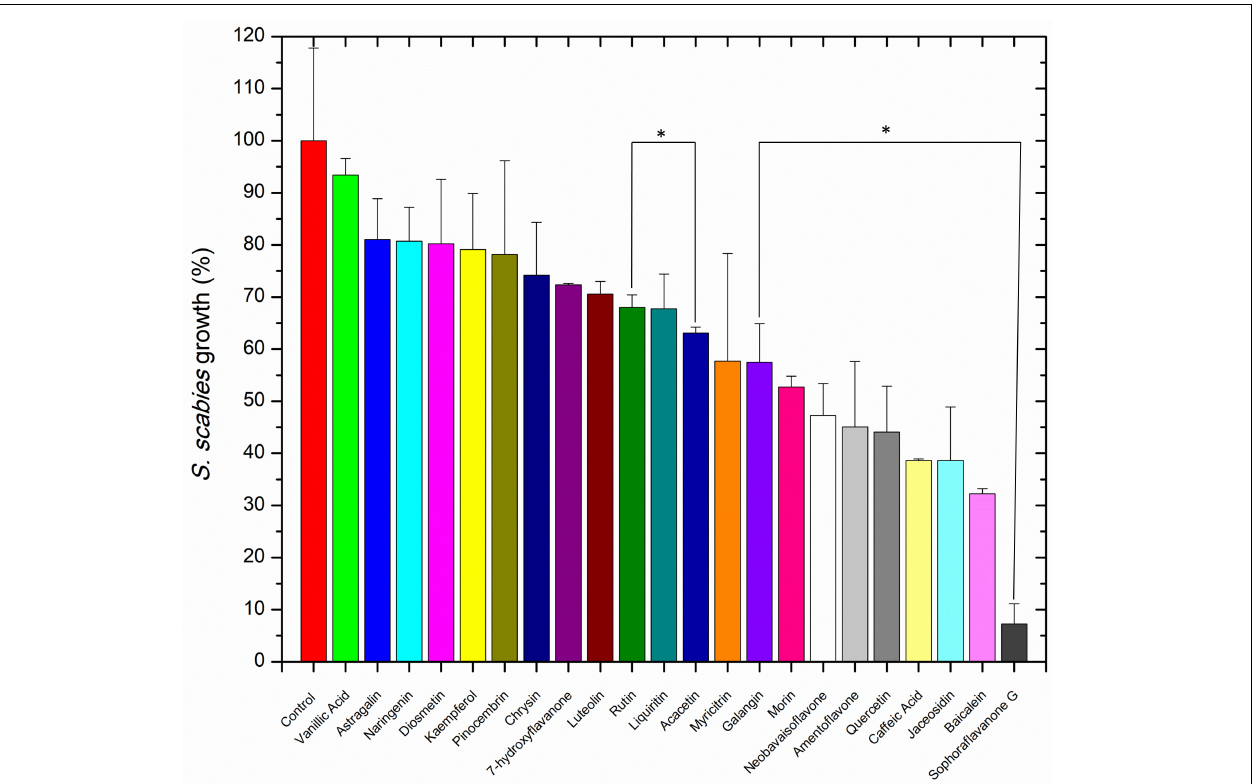
FIGURE 2 | The effect of 100 µ M flavonoid on S. scabies growth . A S. scabies starter culture was grown to an A 660 nm between 0.18 and 0.21, then aliquots of 20 µ L of the starter culture were used to inoculate 1 mL nutrient broth with 1% DMSO, 100 µ M of the flavonoid and a metal spring for shearing the filamentous S. scabies culture. Culture was grown by shaking at 250 rpm at 30 ◦ C for 7 h. Afterward, the level of growth was determined with the MBA. Each bar represents the mean of triplicate experiments ± standard deviation. The control represents S. scabies grown in 1% DMSO in the absence of any flavonoid compound. Each bar represents the mean of triplicate experiments ± standard deviation. Bars marked with an asterisk represent p < 0.05 for the group of datasets.